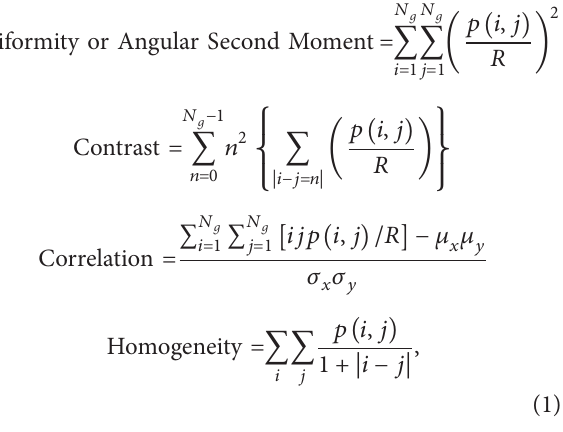
to be the distribution of cooccurring values at a given